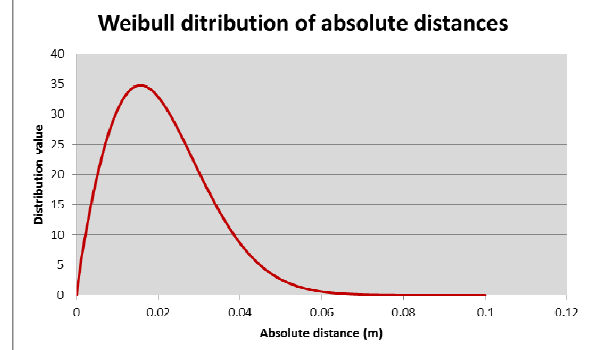
Figure 26: Weibull distribution of absolute distances between the photogrammetric point clouds and the TLS one. Project made using all dataset simultaneously.